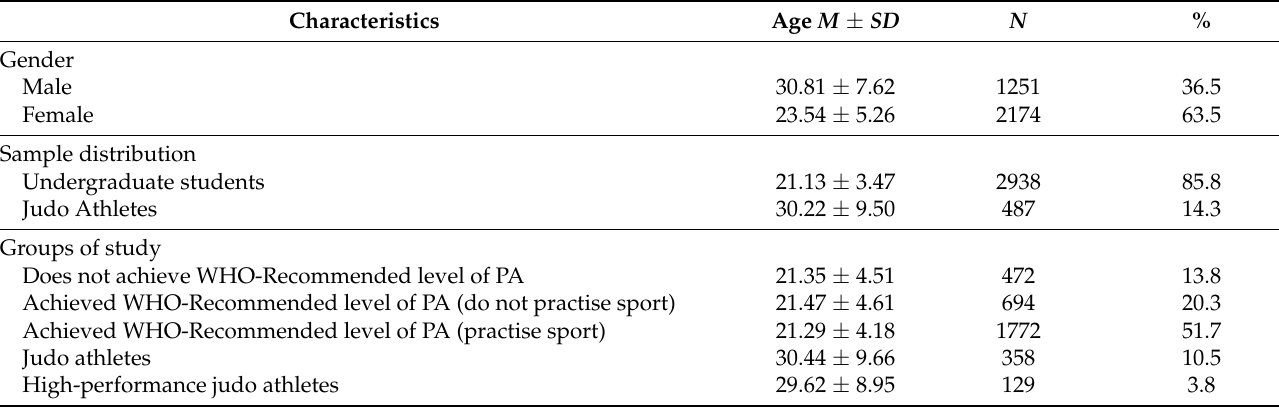
Table 2. Sample distribution and